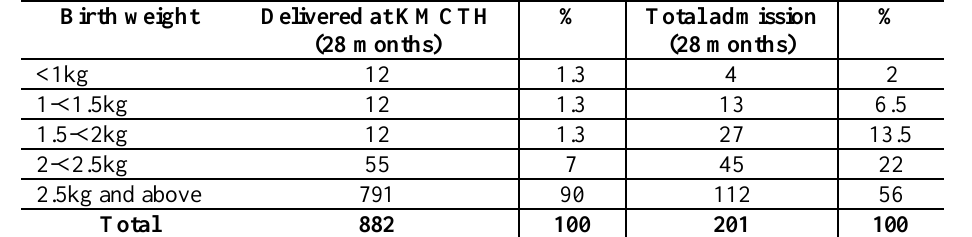
Table I : According to birth weight of the babies born at KMCTH and admitted in the SCBU